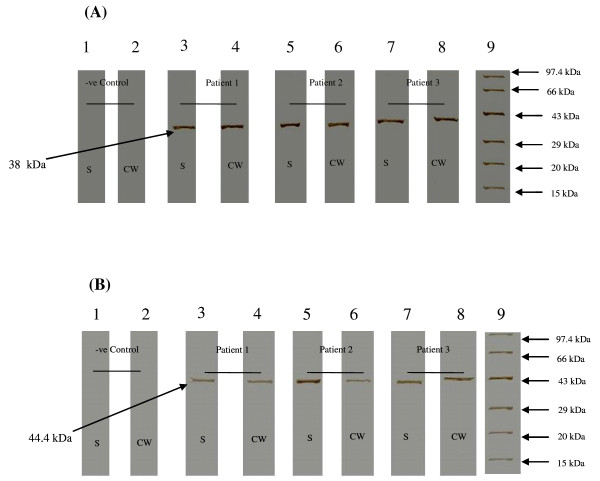
Western blot assay for detection of anti-IncB and anti-IncC IgG antibodies. Detection of (A) anti-IncB IgG and (B) anti-IncC IgG antibodies in sera (S) and cervical washes (CW) obtained from CT-positive patients and controls. Strips 3, 5, 7 – Detection of IncB IgG antibodies in sera (S) of patients' 1, 2, 3 respectively; strips 2, 4, 6- Detection of IncB IgG antibodies in cervical washes (CW) of patients' 1, 2, 3 respectively; strips 1, 2 – Serum and cervical wash respectively obtained from CT-negative patient (which served as negative controls for assay). Strip 9 – Molecular weight marker (Bangalore Genei). A 38 kDa band (IncB specific IgG) and 44.4 kDa band (IncC specific IgG) was detected in sera and cervical washes obtained from CT-positive patients. No bands were observed in negative control. IncB- CT Inclusion membrane protein B; IncC- CT Inclusion membrane protein C; CT- Chlamydia trachomatis; kDa- Kilodaltons; S- Serum; CW- Cervical washes.